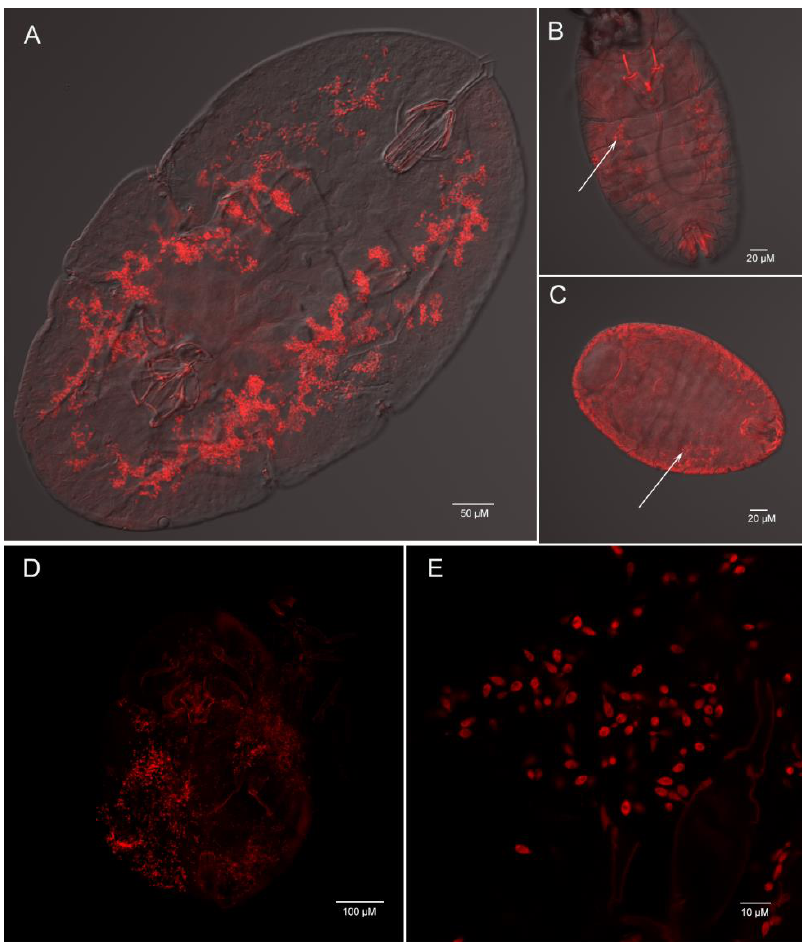
Figure 8. Whole mount fluorescence in situ hybridization of Ophiocordyceps fungi (red) in Ceroplastes rubens ( A , B , C ) and Ceroplastes japonicus ( D , E ). Nymph ( A ), new nymph ( B ) and egg ( C ) of Ceroplastes rubens ; ( D ) nymph of Ceroplastes japonicus ; ( E ) high magnification of Ophiocordyceps cells in Ceroplastes japonicus . The arrows show the location of Ophiocordyceps fungi.